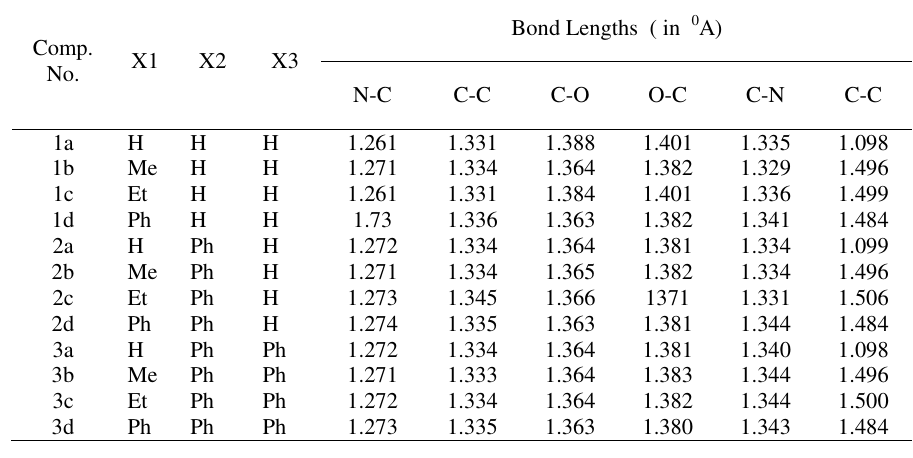
Table 4 The bond length values for the X1, X2 and X3 Positions as obtained from the Z-matrix parameters developed by PC-Model